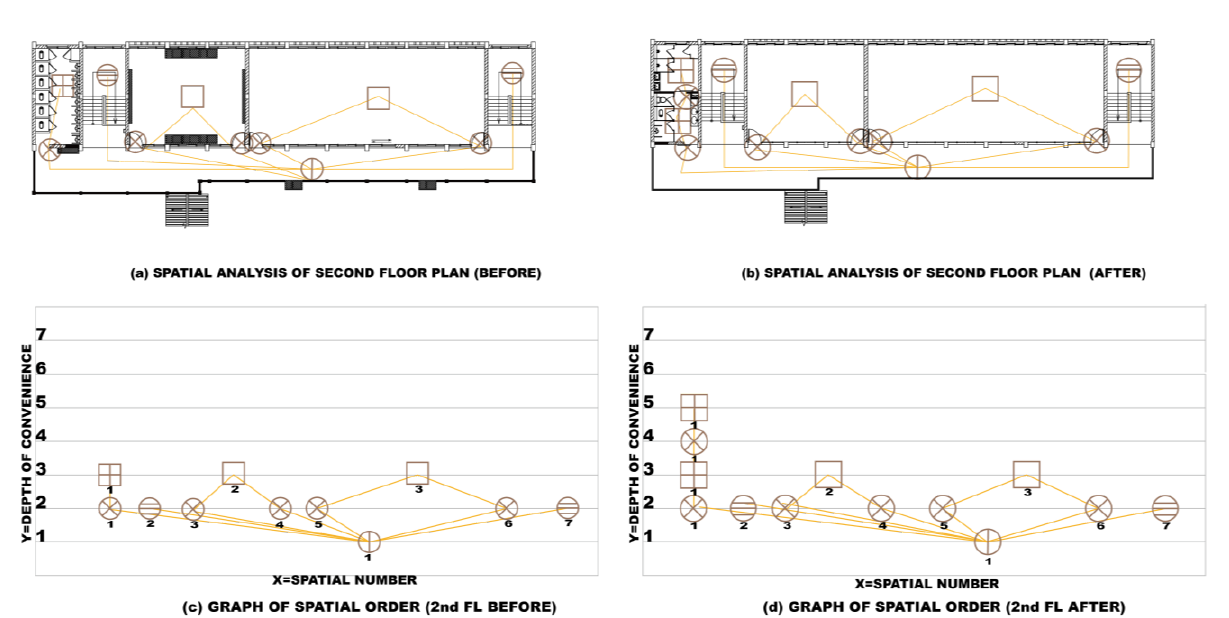
Figure 9. Past and Present ’s Regeneration Second Floor Plans of Che cheng Elementary School Wencyuan Branch’s Space Relationship Diagrams. ( a ) Spatial Analysis (Before redesign). ( b ) Spatial Analysis (After redesign). ( c ) Spatial Order (Before redesign). ( d ) Spatial Order (After redesign).